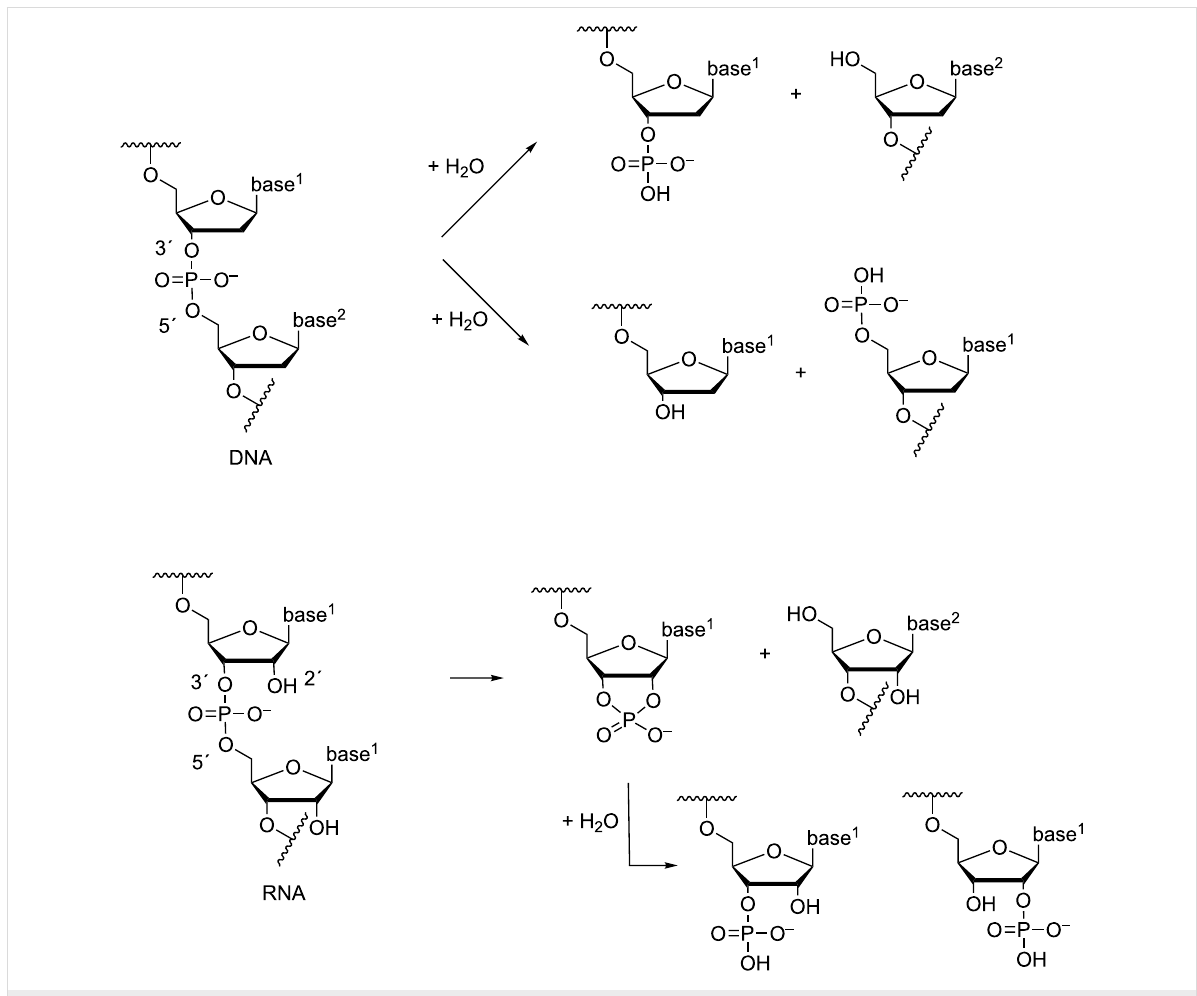
Figure 1: Enzymatic cleavage of phosphodiester linkages of DNA and RNA.